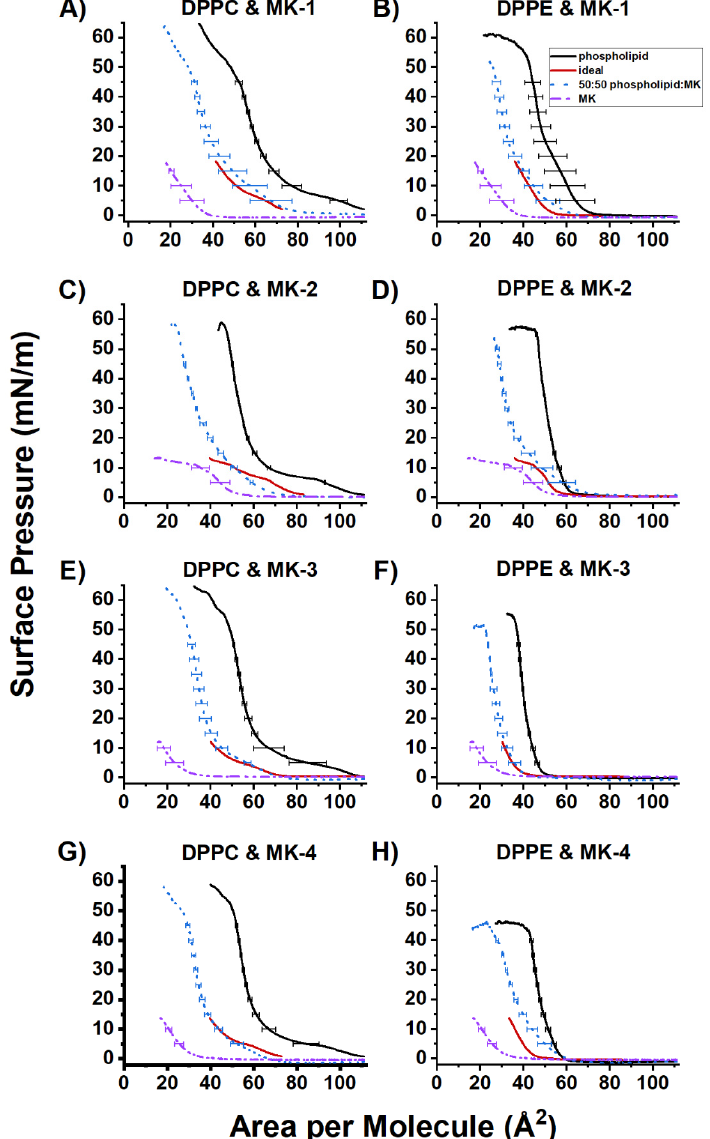
Figure 6. Ideal mixing of 50:50 phospholipid:MK films compared to experimental data. DPPC films are in the left column. DPPE films are in the right column. ( A ) and ( B ) show MK-1 mixed films, ( C ) and ( D ) show MK-2 mixed films, ( E ) and ( F ) show MK-3 mixed films, and ( G ) and ( H ) show MK-4 films. Solid black curves are pure phospholipid monolayers. Blue dotted curves represent experimental 50:50 phospholipid:MK films. Solid red curves represent calculated ideal mixed films. Purple dash-dot-dot curves represent pure MK films. Each MK homologue experiments were run independently, hence differences in control isotherms were observed.